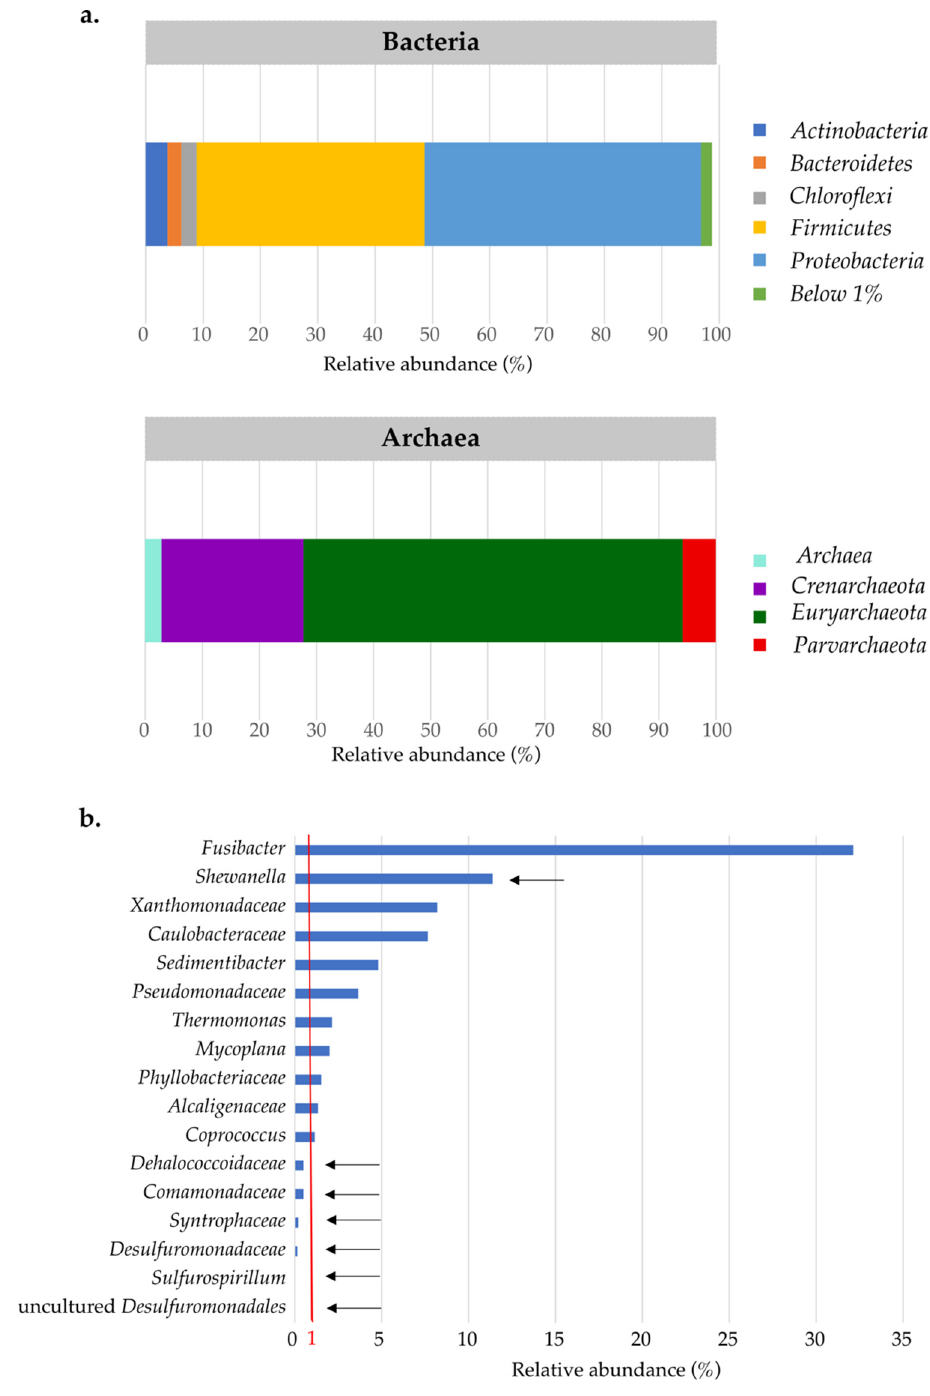
Figure 2. Composition of the active microbial community resident in groundwater underneath the landfill sampled at Pz22, as determined by RNA-based Illumina sequencing of 16S rRNA of Archaea and Bacteria at phylum level ( a ). Active bacterial genera present in Pz22 either with a relative abundance above 1% or that are inferred as OHRB according to the literature ( b ); arrows indicate OHRB genera or